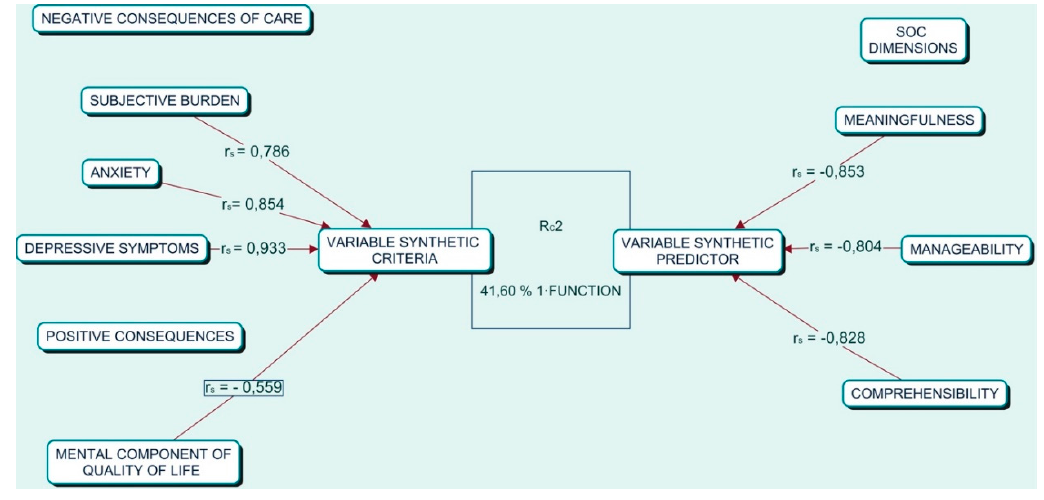
Figure 1. Conceptual model of canonical correlation.